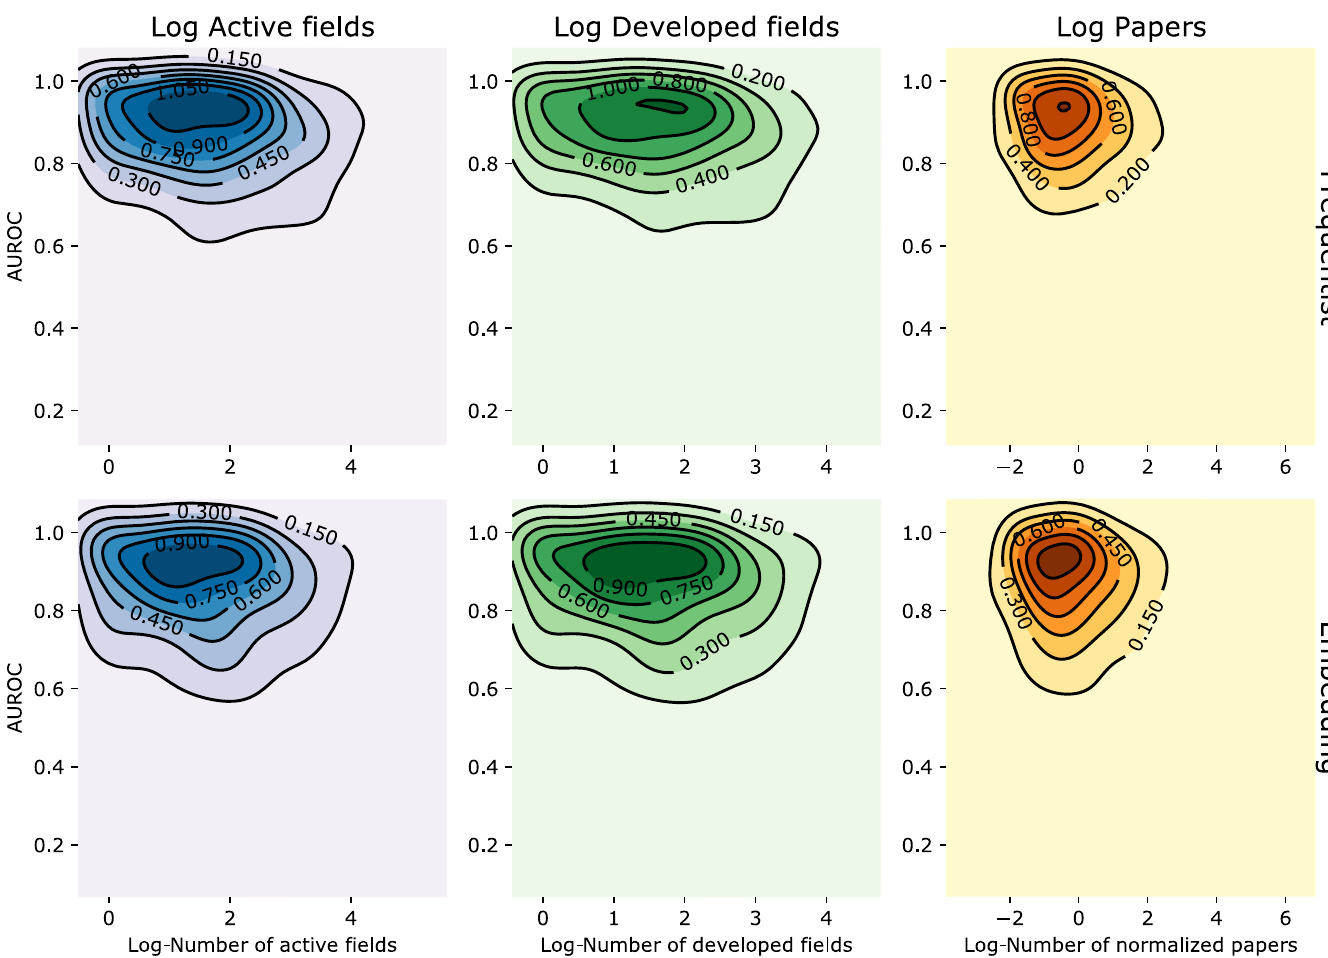
Fig 8. AUROC distribution for institutions vs. data properties. Empirical distributions of the AUROC as a function of the logarithms of the (i) number of active fields, (ii) number of developed fields and (iii) normalized number of papers. Time windows are set as in the first experimental setup. Contour plots were created from 500 sample points using Gaussian